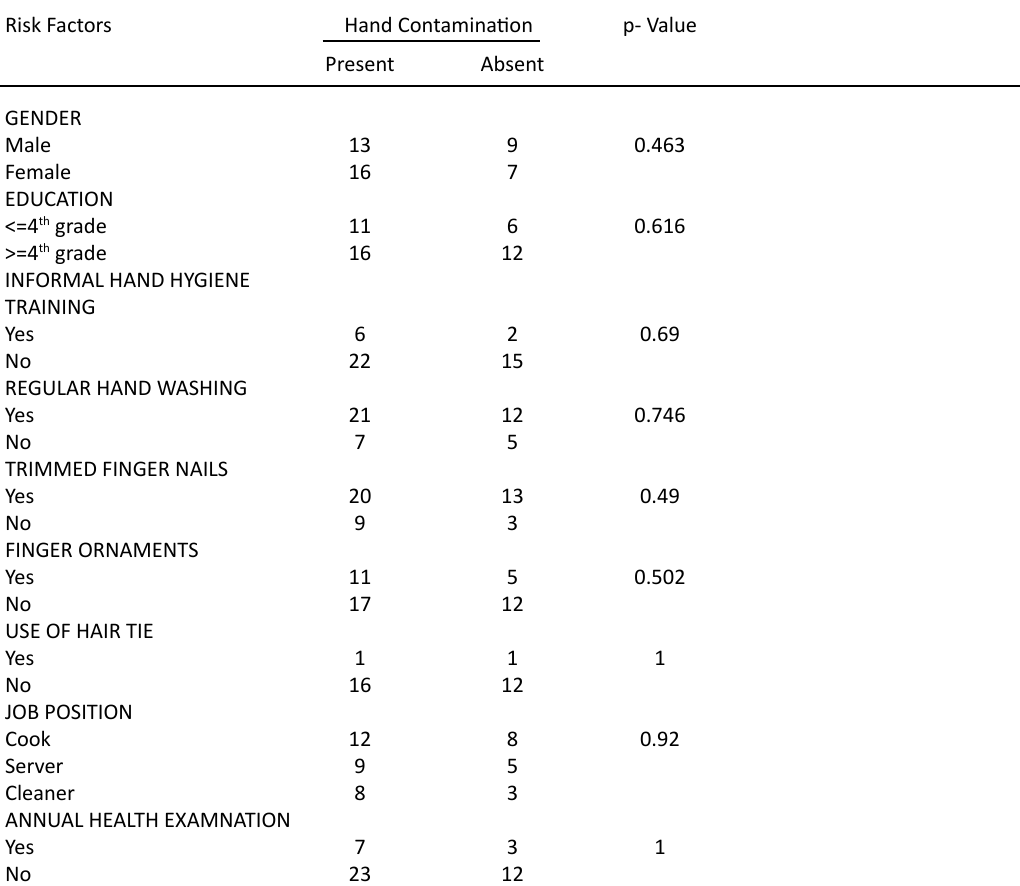
Table 7. The association between hand contamination and various risk factors found using Chi square test and Fisher Exact